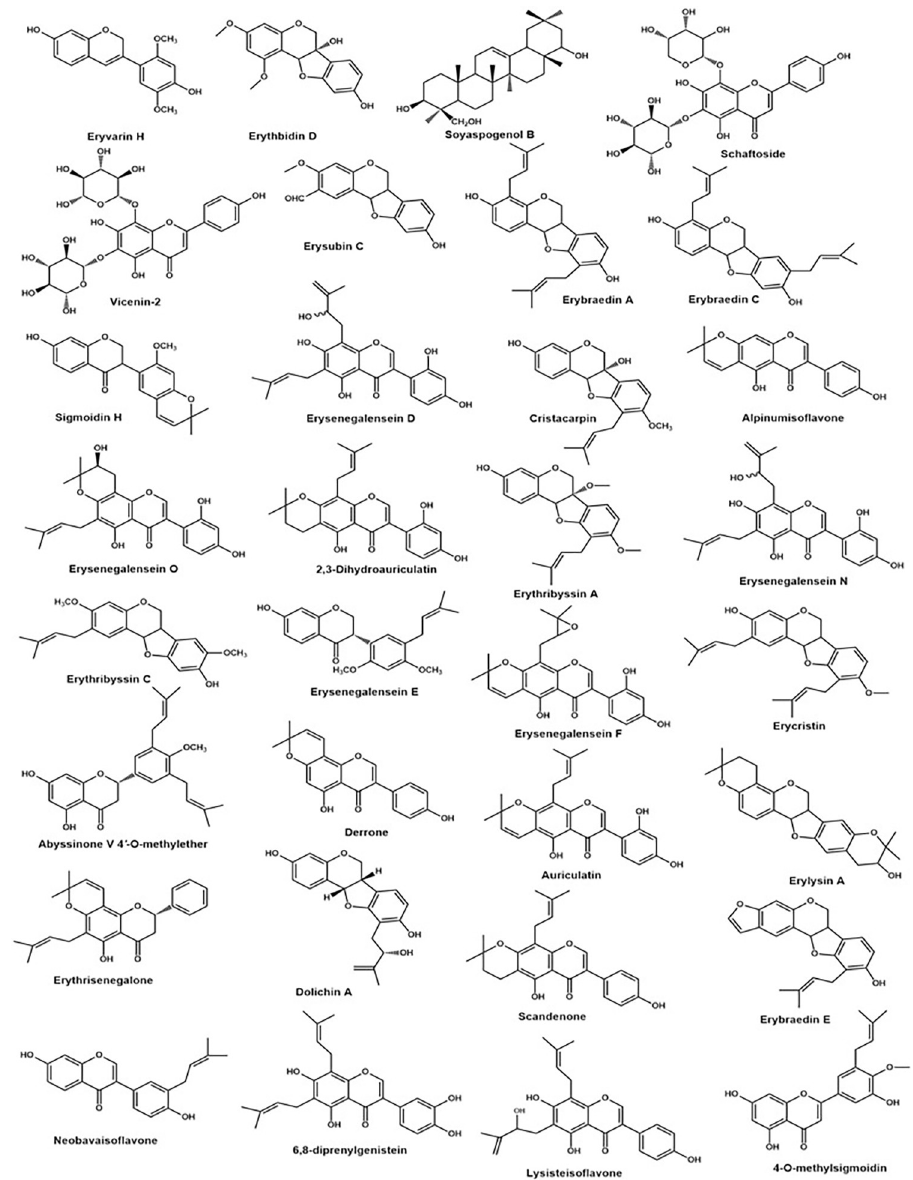
Fig 1. Chemical structures of some compounds identified in the 70% ethanol stem bark extract of E . senegalensis .